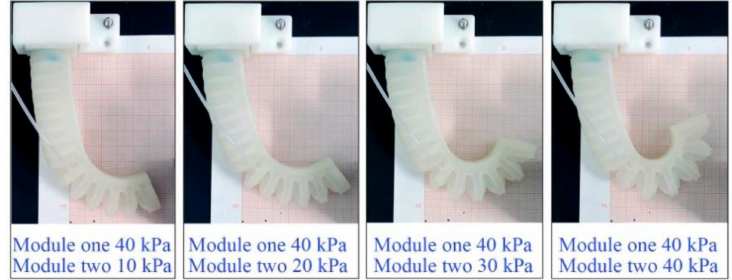
Figure 9. Deformation of the proposed actuator under different pressures.